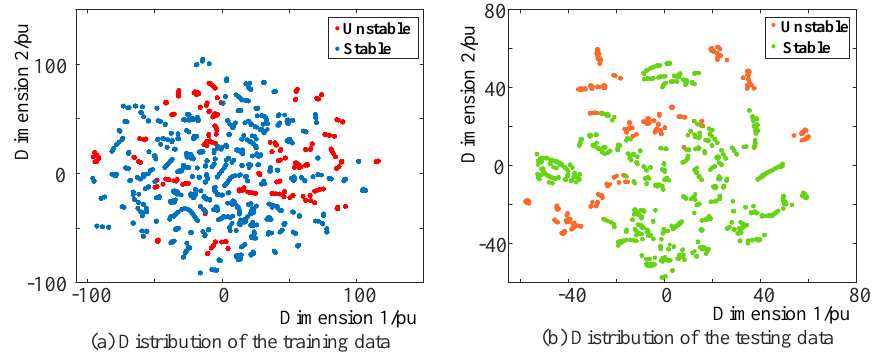
Figure 8. Distributions of training and testing data generated from the target GDPG.